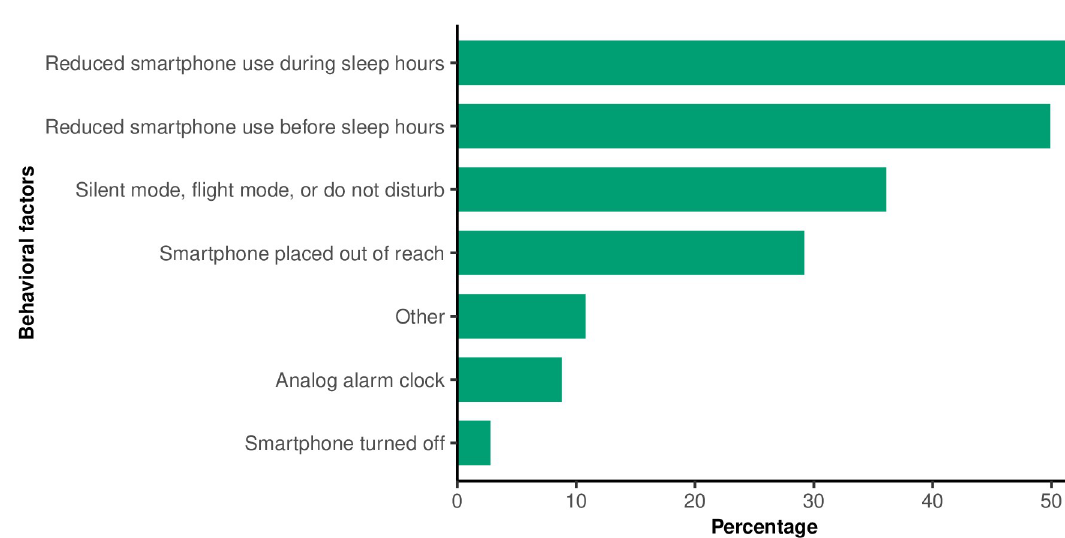
Fig 3. The behavioral factors for changes in night-time smartphone behavior among 720 participants who changed behavior in the SmartSleep Experiment .